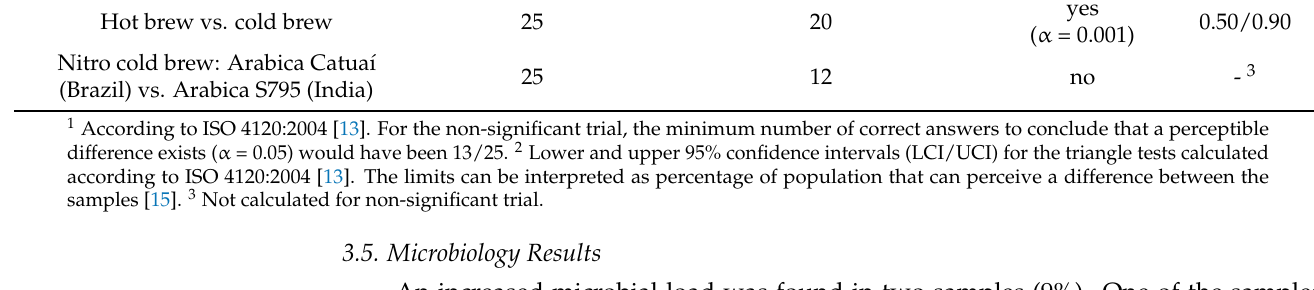
Table 5. Results of the ISO 4120:2004 sensory analysis using triangle testing for differentiation of cold brew coffee. Test Material No. of Assessors No. of Correct Responses Significance 1 LCI/UCI 2 Hot brew vs. cold brew 25 0.50/0.90 Nitro cold brew: Arabica Catua